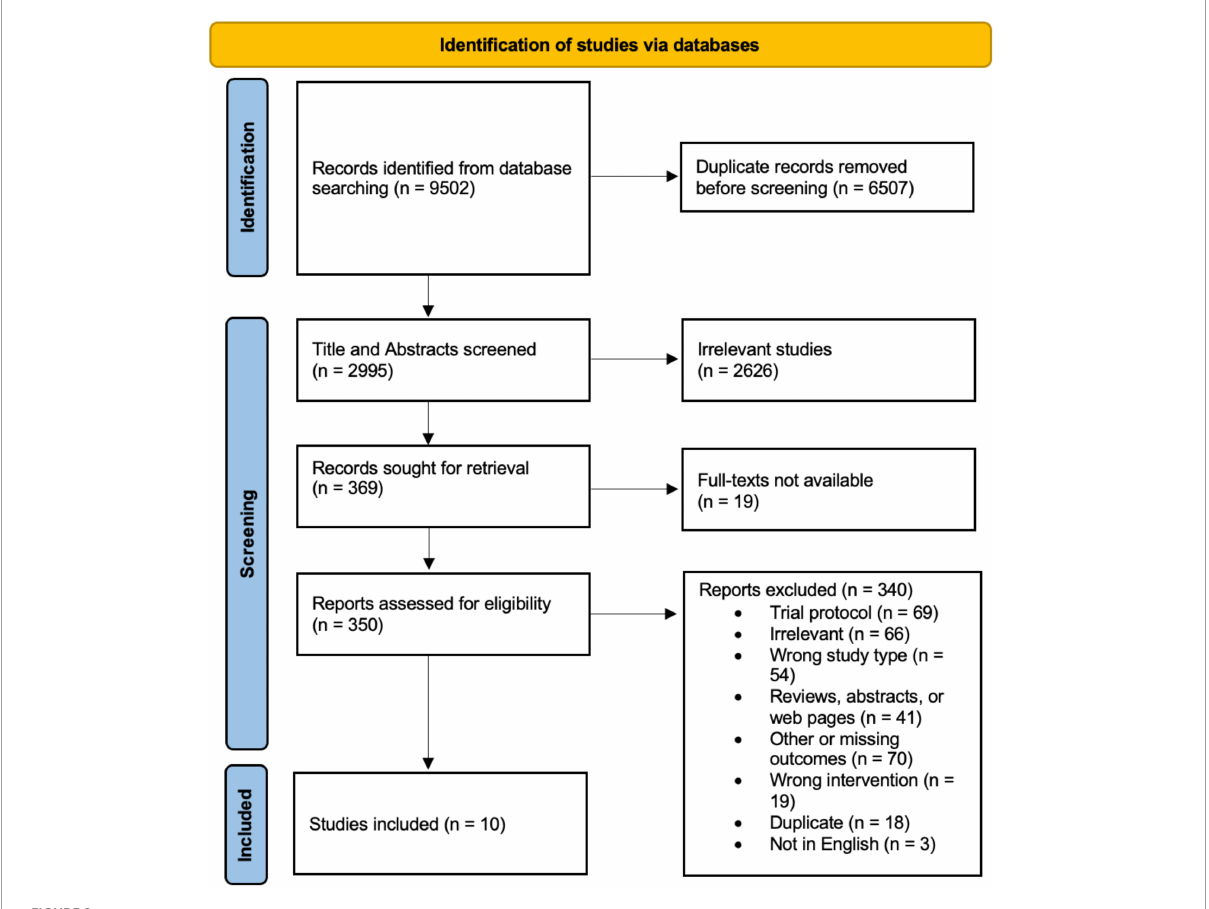
FIGURE2 PRISMA study selection flow